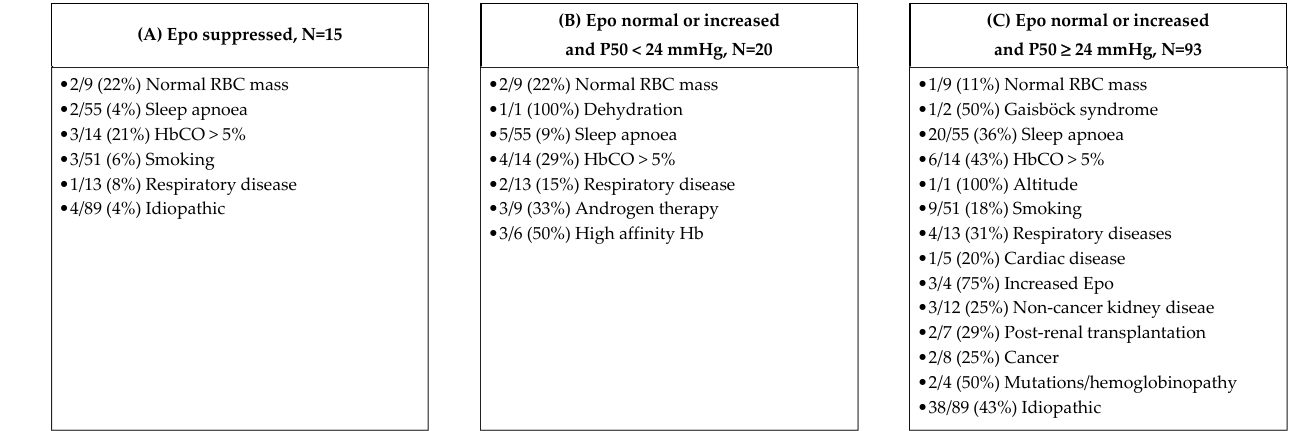
Figure 4. Causes identified in relation to Epo level and P50 levels. Numbers and percentages are reported in relation to the number of patients with the particular cause. Zero entries are omitted. Patients with missing values are not included.